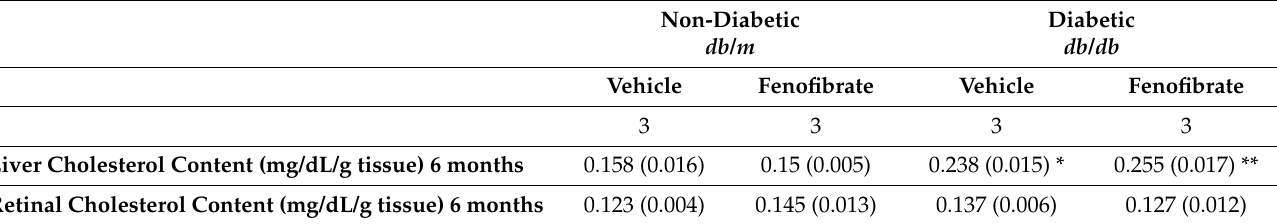
Table 3. Tissue lipid content of fenofibrate-treated mice in a model of type 2 diabetes.